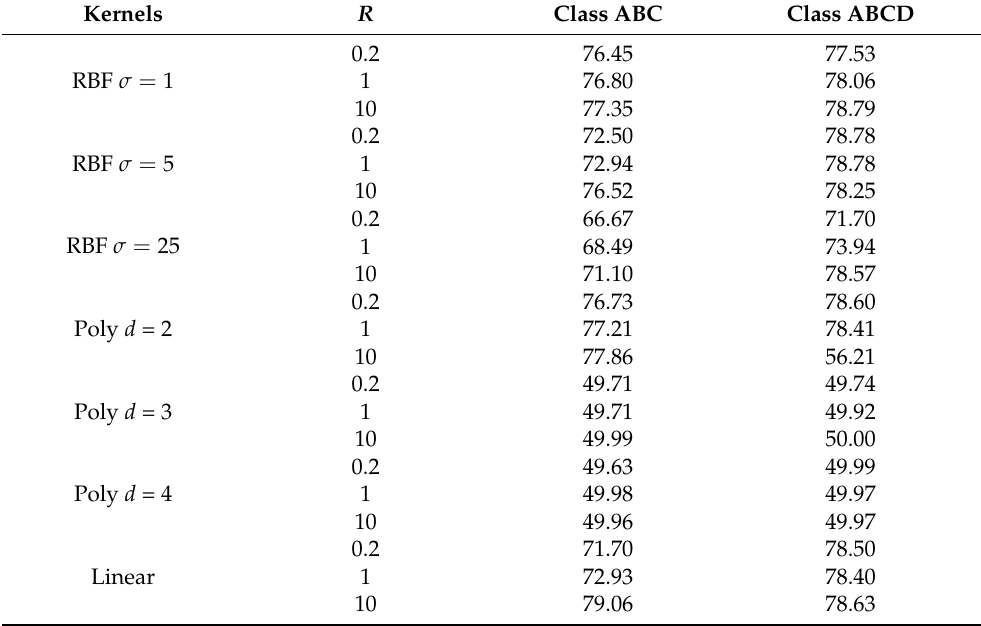
Table 5. AUC (%) obtained from SVM models with different kernels and parameters using Class ABC and ABCD in the experiment with event duration.